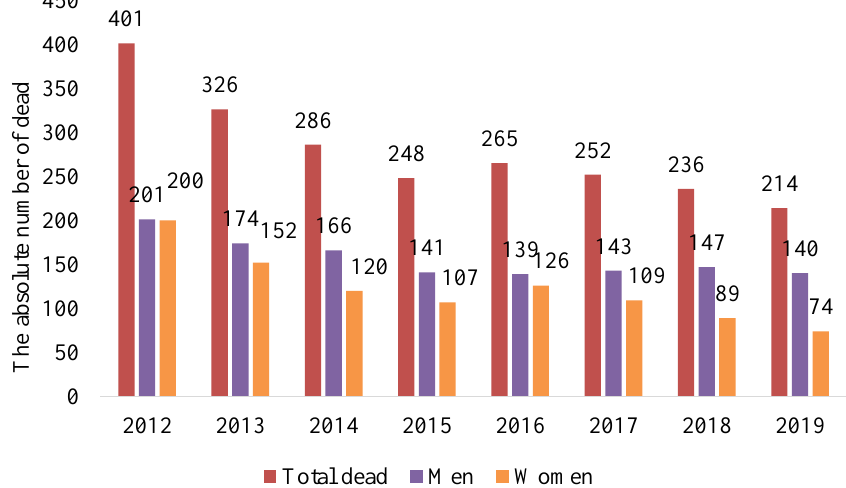
Fig. 3. Analysis of the dynamics of change and structure of the population (gender) of LGM deaths during 2012–2018 (2019 results of forecasting relevant indicators) in Ukraine.